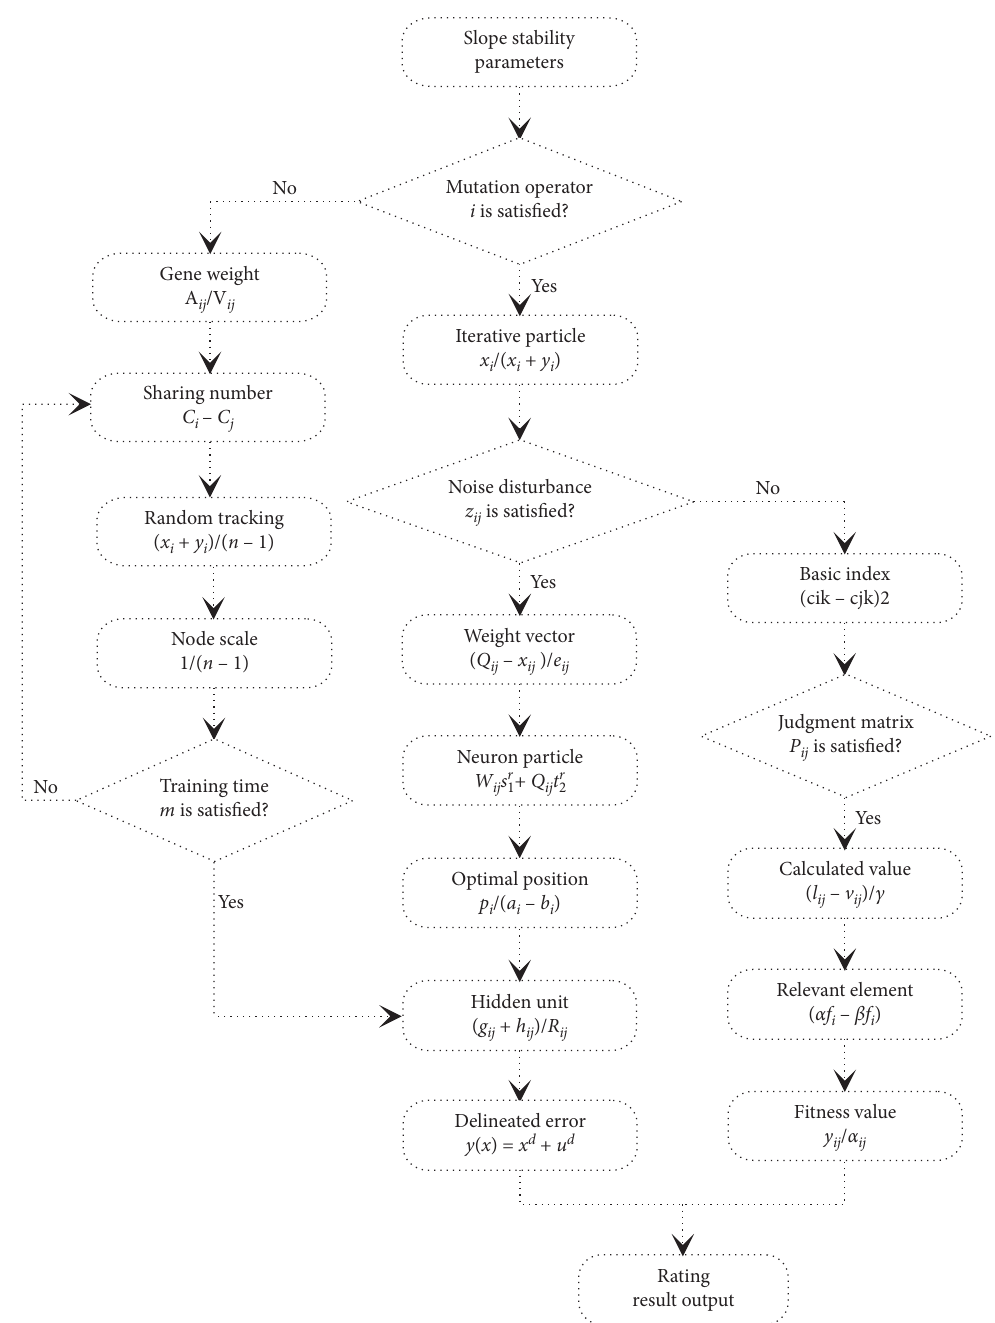
Figure 3: Flowchart of the artificial intelligence-based rating algorithm for mine rock slope